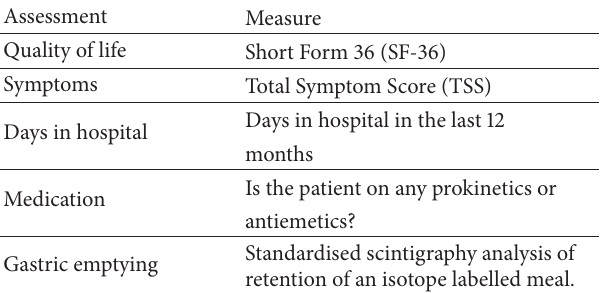
Table 3: Minimum criteria for insertion and reporting outcomes of gastric electrical stimulation